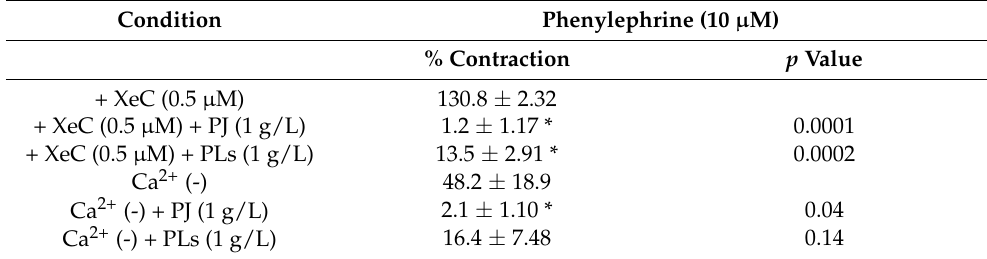
Contractions (mean ± standard error of mean) are expressed as a percentage of the previous tone induced by potassium chloride (60 mM). * p < 0.05 vs. each control (Dunnett’s test). n =